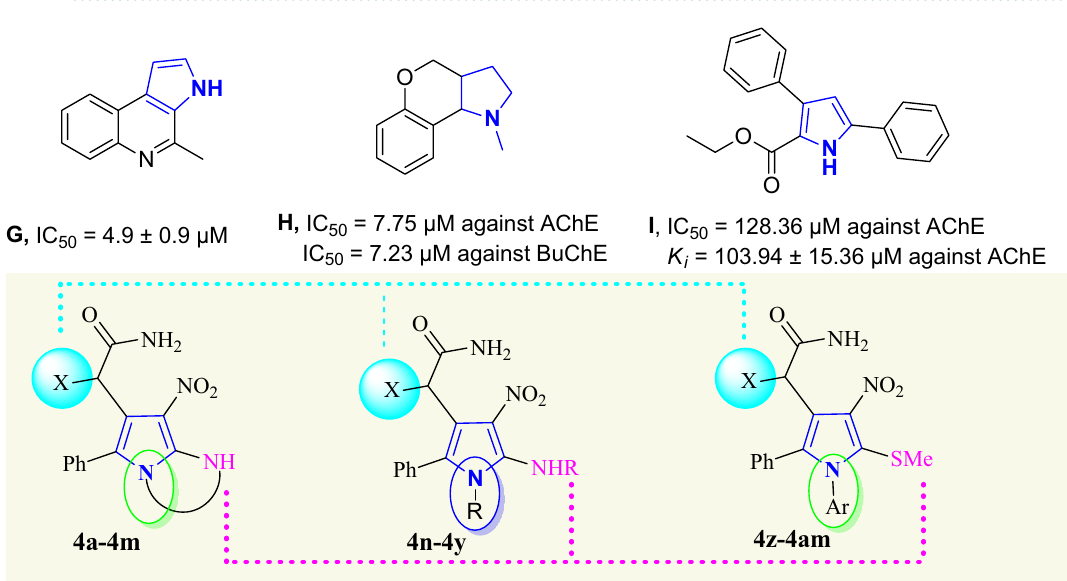
Figure 2. Traditional AChE inhibitors including donepezil hydrochloride as an FDA-approved AChE inhibitor and related structures.